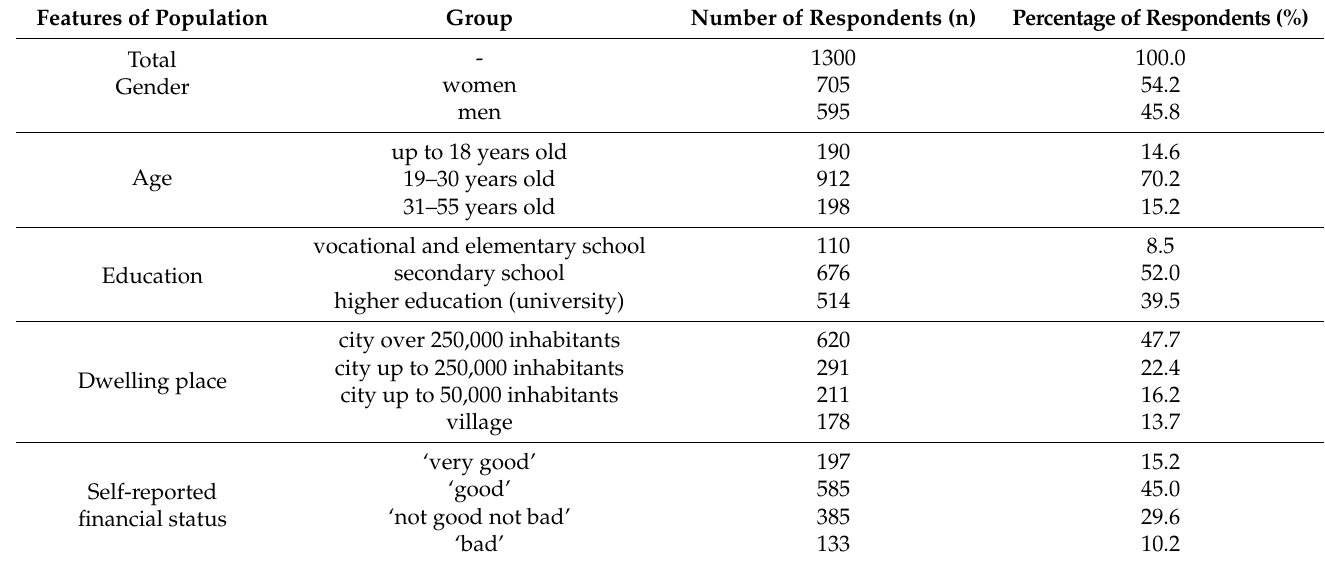
Table 1. Characteristic of